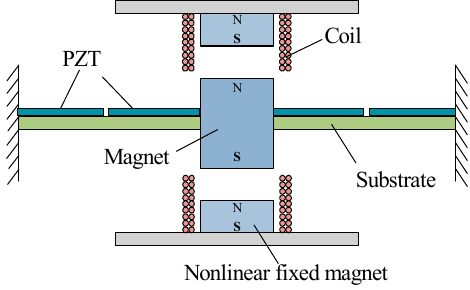
Figure 1. Structure model of nonlinear hybrid energy harvester.